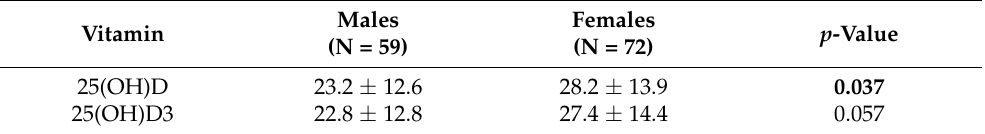
Table 2. Total 25-Hydroxyvitamin D and 25-Hydroxyvitamin D3 differentiated by sex in adults with a history of COVID-19 (N = 131).